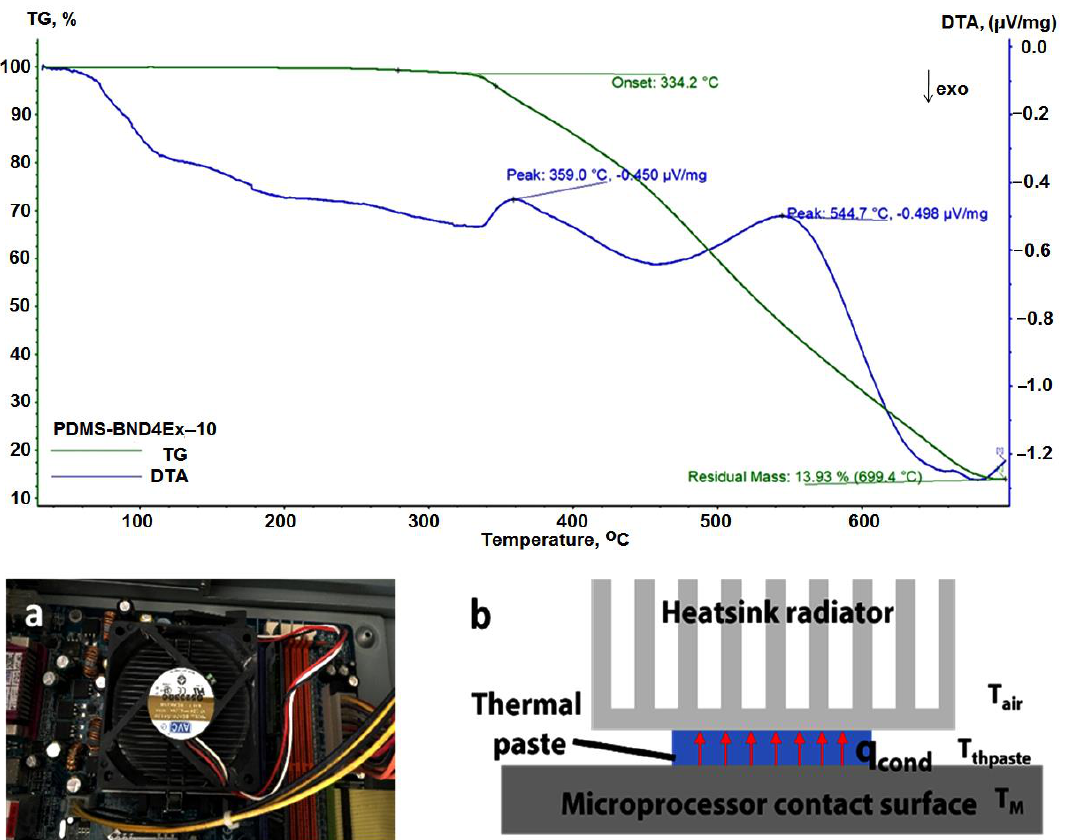
Figure 10. Thermogravimetric curve for the PDMS-BND4Ex-10 ( top ); top picture of the heatsink setup ( a ); schematics of the cooling setup with thermal paste ( b ) ( down ). Table 3. Thermal parameters of the composites.